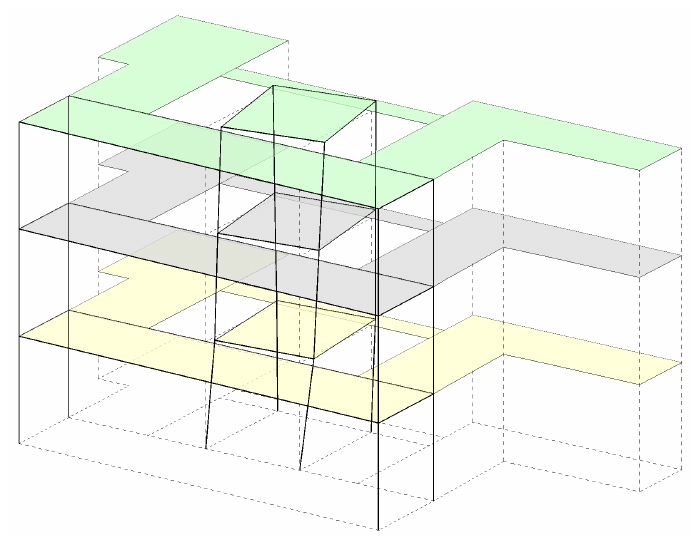
Figure 8. Torsional mode around axis Z. Weakly coupled with Y translation.